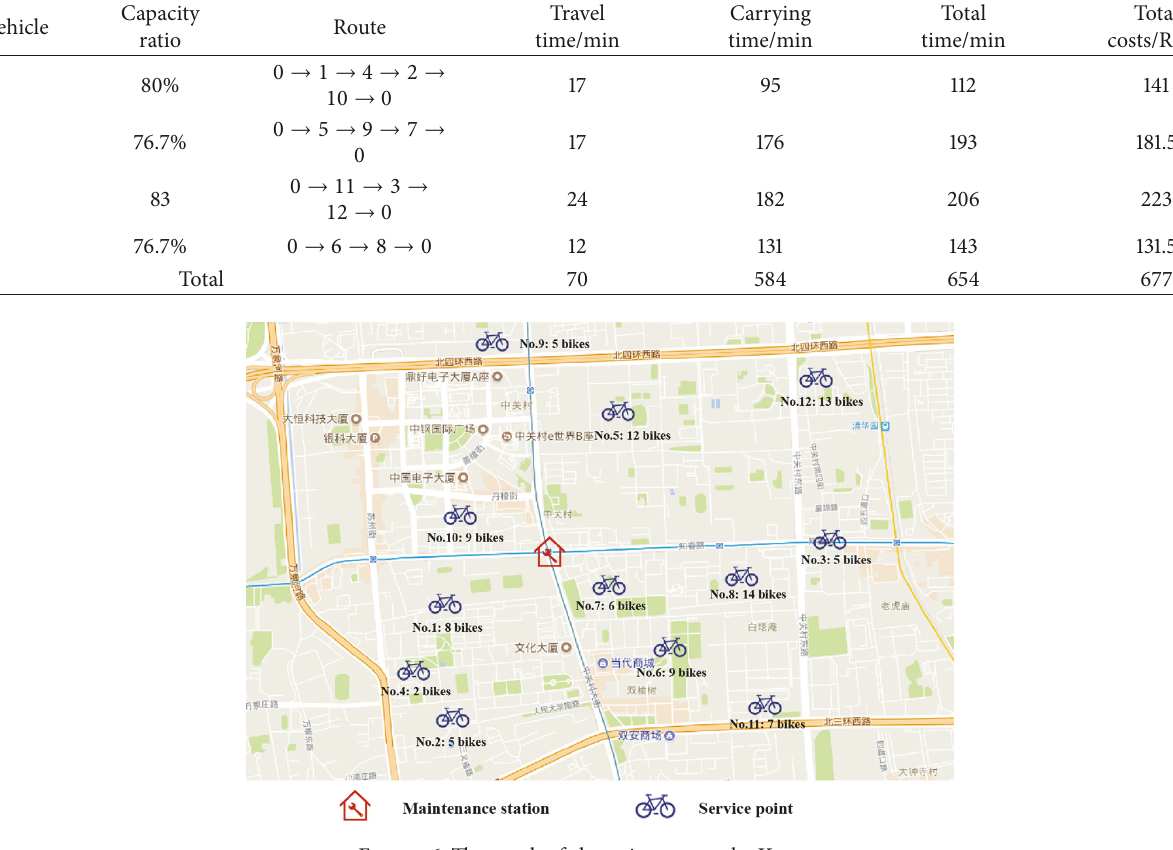
Figure 6: The graph of clustering centers by K-means.